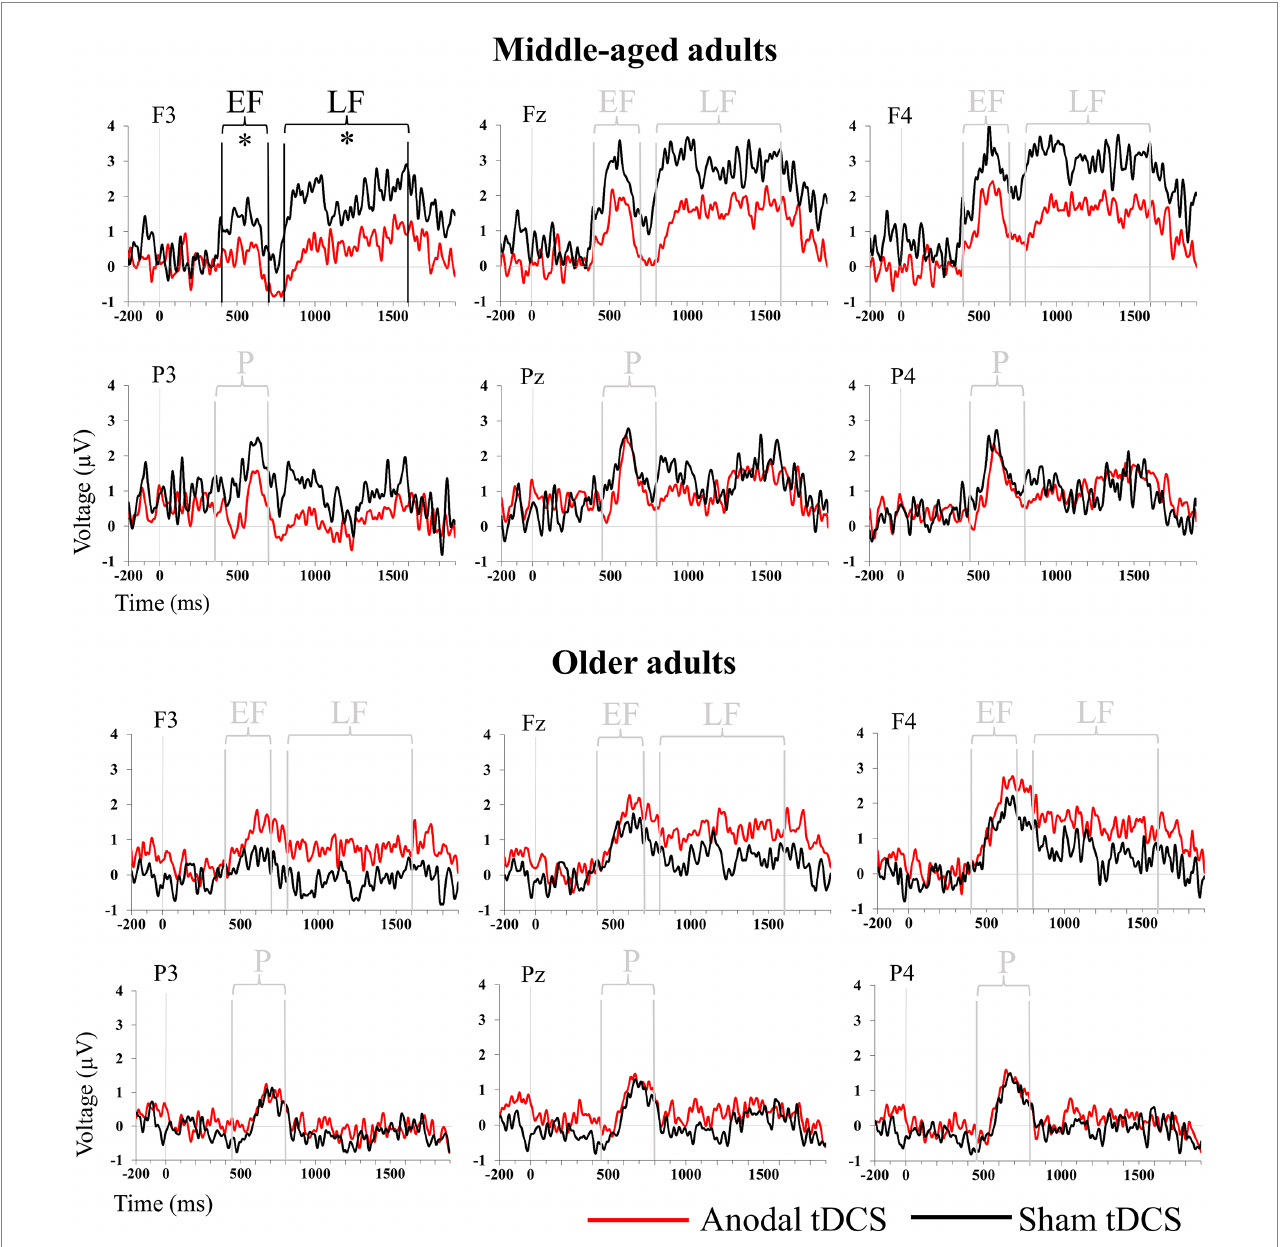
FIGURE 3 Grand-average ERP waveforms elicited by the old stimuli (hit) in the Anodal (red line) and Sham (black line) sessions for the middle-aged (upper panel) and older (lower panel) adults at the F3, Fz, F4, P3, Pz, and P4 electrodes. Vertical lines highlight the time window considered for the different ERP components. Black vertical lines with an asterisk indicate statistically significant differences between the anodal and sham conditions. EF, Early Frontal Old-New effect; LF, Late Frontal Old-New effect; P, Parietal Old-New effect. * indicates a significant